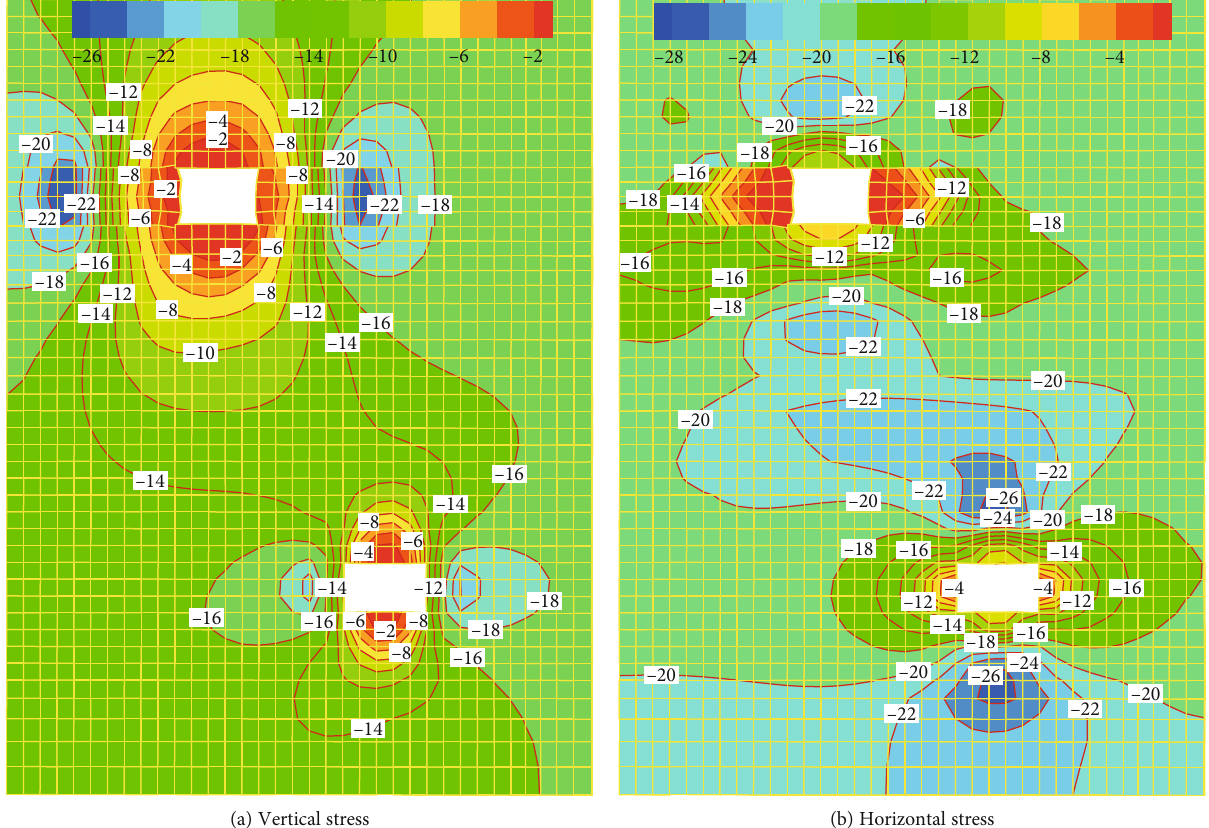
Figure 17: Distribution law of stress fi eld in surrounding rock of roadway after excavation.